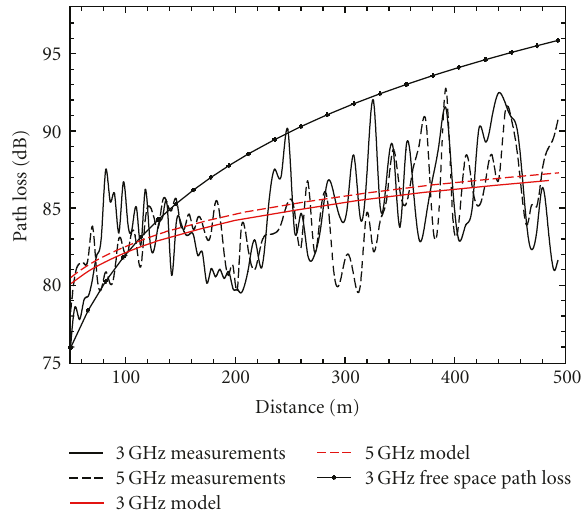
Figure 5: Average path loss (curves “measurements”) and mean path loss deduced from the model (curves “model”) at 3 and 5GHz.